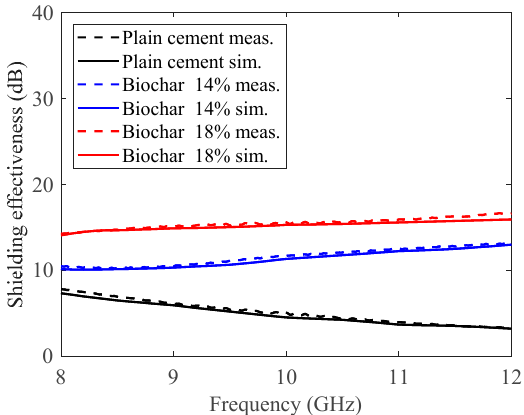
Figure 7. Measured and simulated shielding effectiveness values for plain cement, as well as the sample with 14 wt.% biochar and the sample with 18 wt.%. Samples were cured for seven days in water. Measurements were performed after 10 weeks of aging.